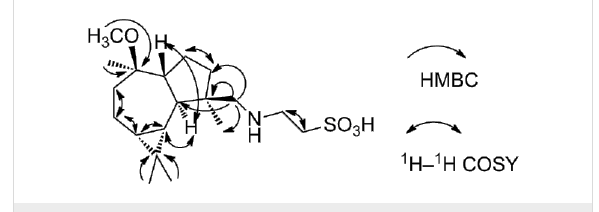
Figure 4: Key HMBC and 1 H– 1 H COSY correlations of 6